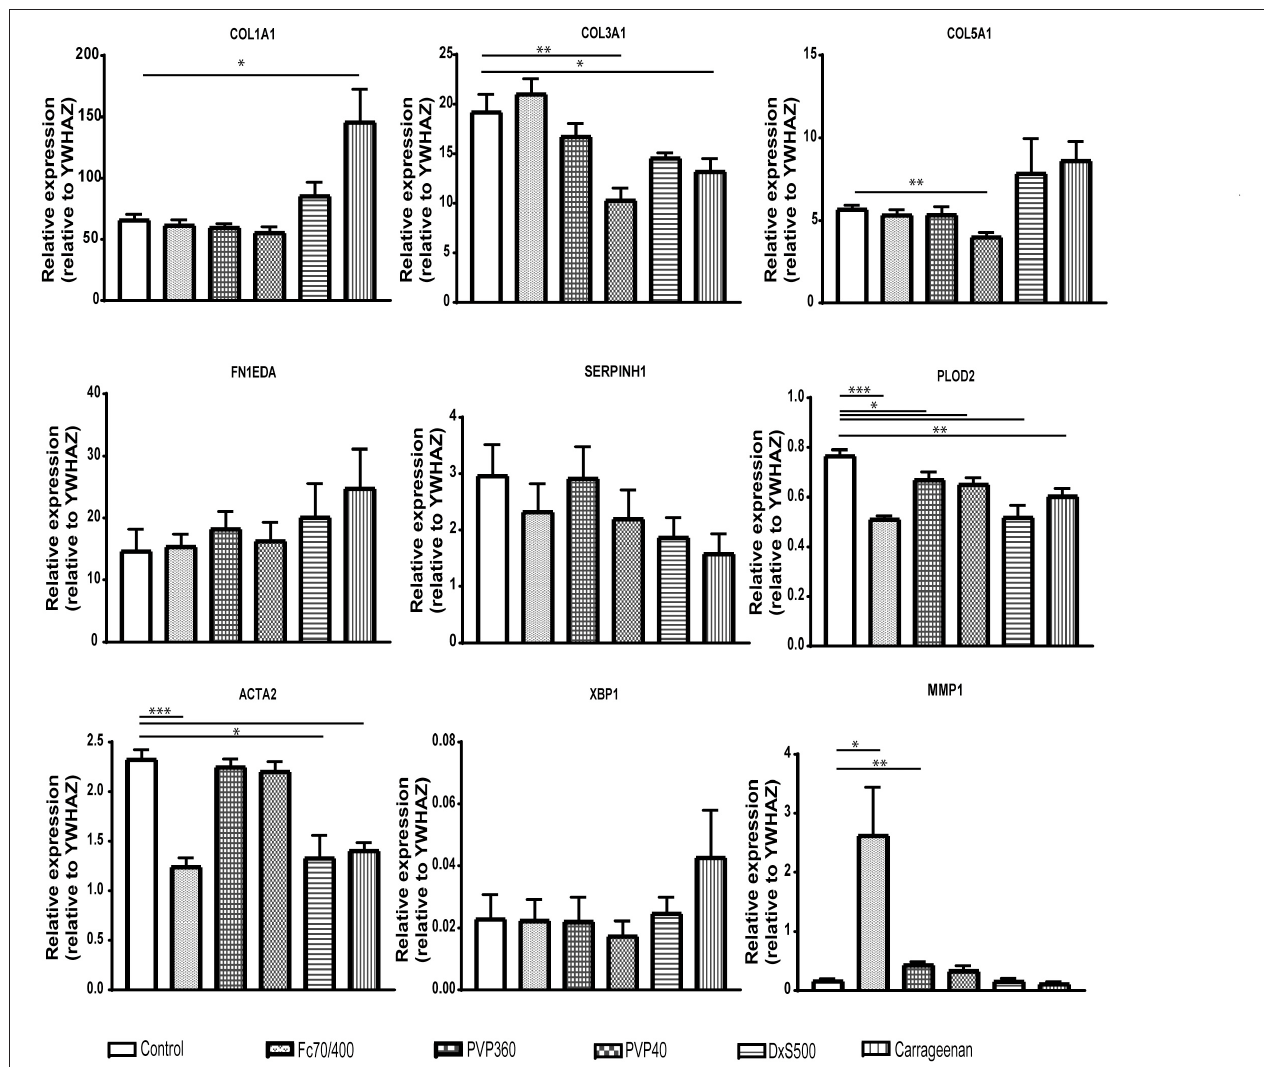
FIGURE 5 | Effects of macromolecular crowders on fibrotic markers in dermal myofibroblasts. mRNA expression of COL1A1, COL3A1, COL5A1, FN1EDA, SERPINH1, PLOD2, ACTA2, XBP1, and MMP1 in human dermal myofibroblasts ( n = 4) after 96h in the presence of TGF β 1, cultured with macromolecular crowders Fc70/400 mixture, PVP360, PVP40, DxS500, and CR vs. control. * = P ≤ 0.05; ** = P ≤ 0.01; *** = P ≤